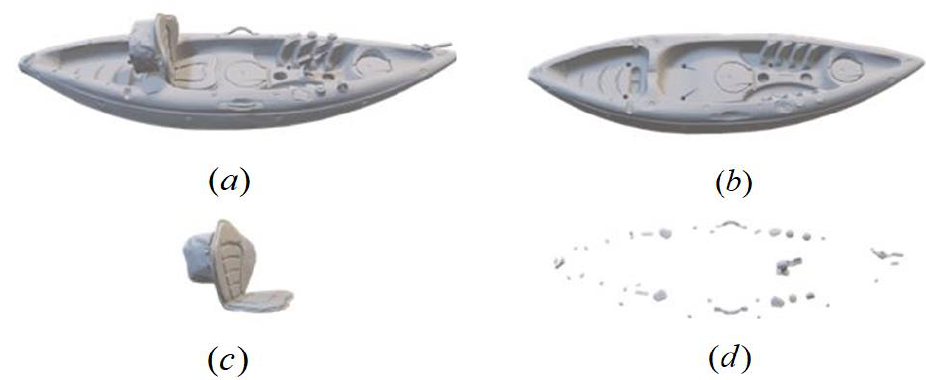
Figure 12. Material of the assault boat: ( a ) main boat body; ( b ) bottom plate (fiber-reinforced plastics); ( c ) seat plate (special steel); ( d ) accessories of the assault boat (copper nickel).